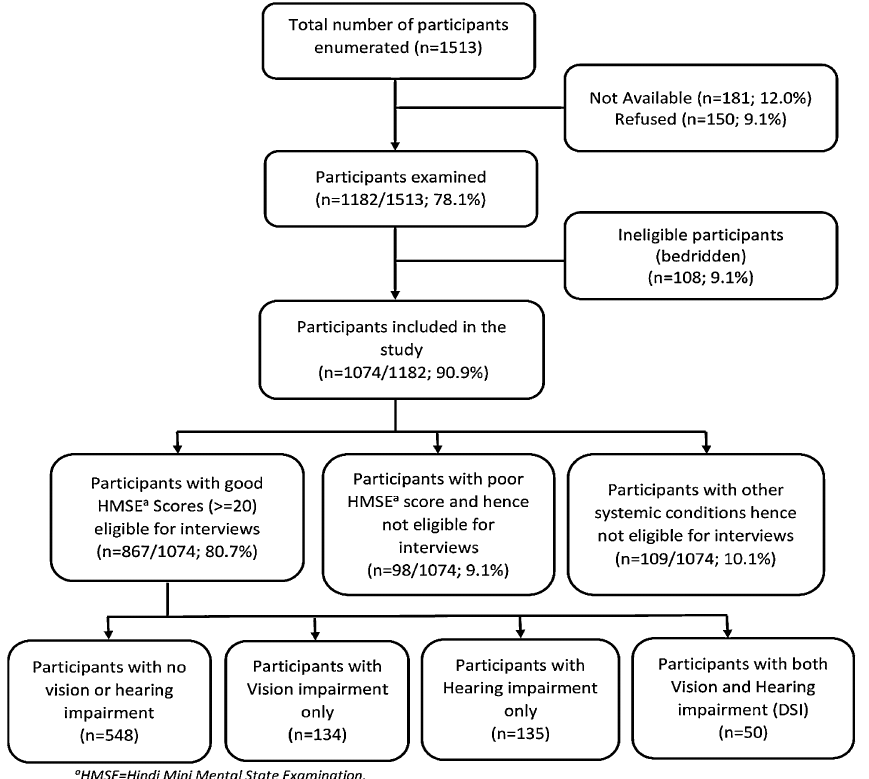
Figure 1. Flowchart showing the study participants with inclusion and exclusion criteria (n =